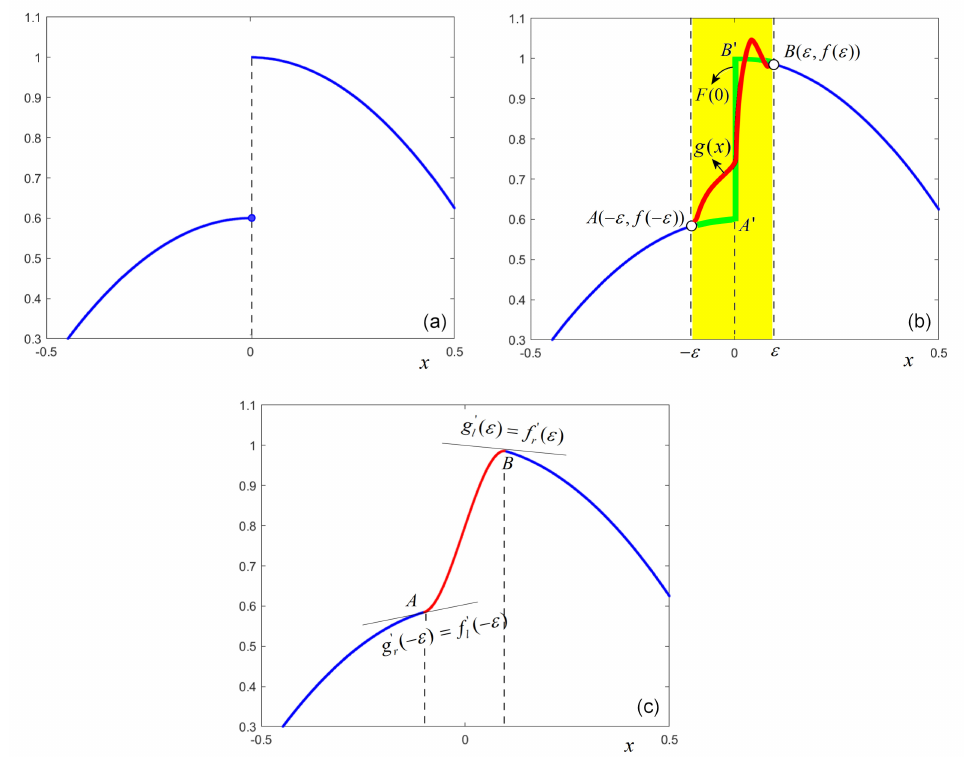
Figure 3. ( a ) Graph of the discontinuous function f for m = 0.6 and p = 1.5; ( b ) The underlying set-valued function F (green plot) defined on the neighborhood [ − ε , ε ] (yellow) together with a continuous selection g connecting points A and B (red); ( c ) The graph of the obtained smooth function ˜ f : R → R